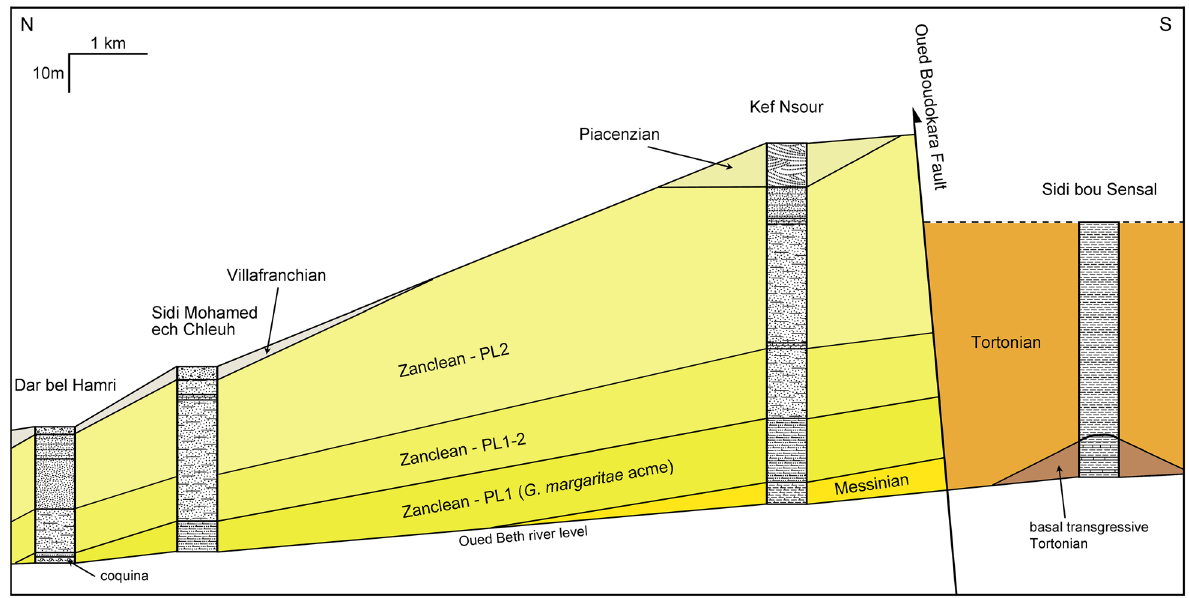
Fig. 4 Schematized outcrop-section along the Oued Beth right river bank based on studied sections